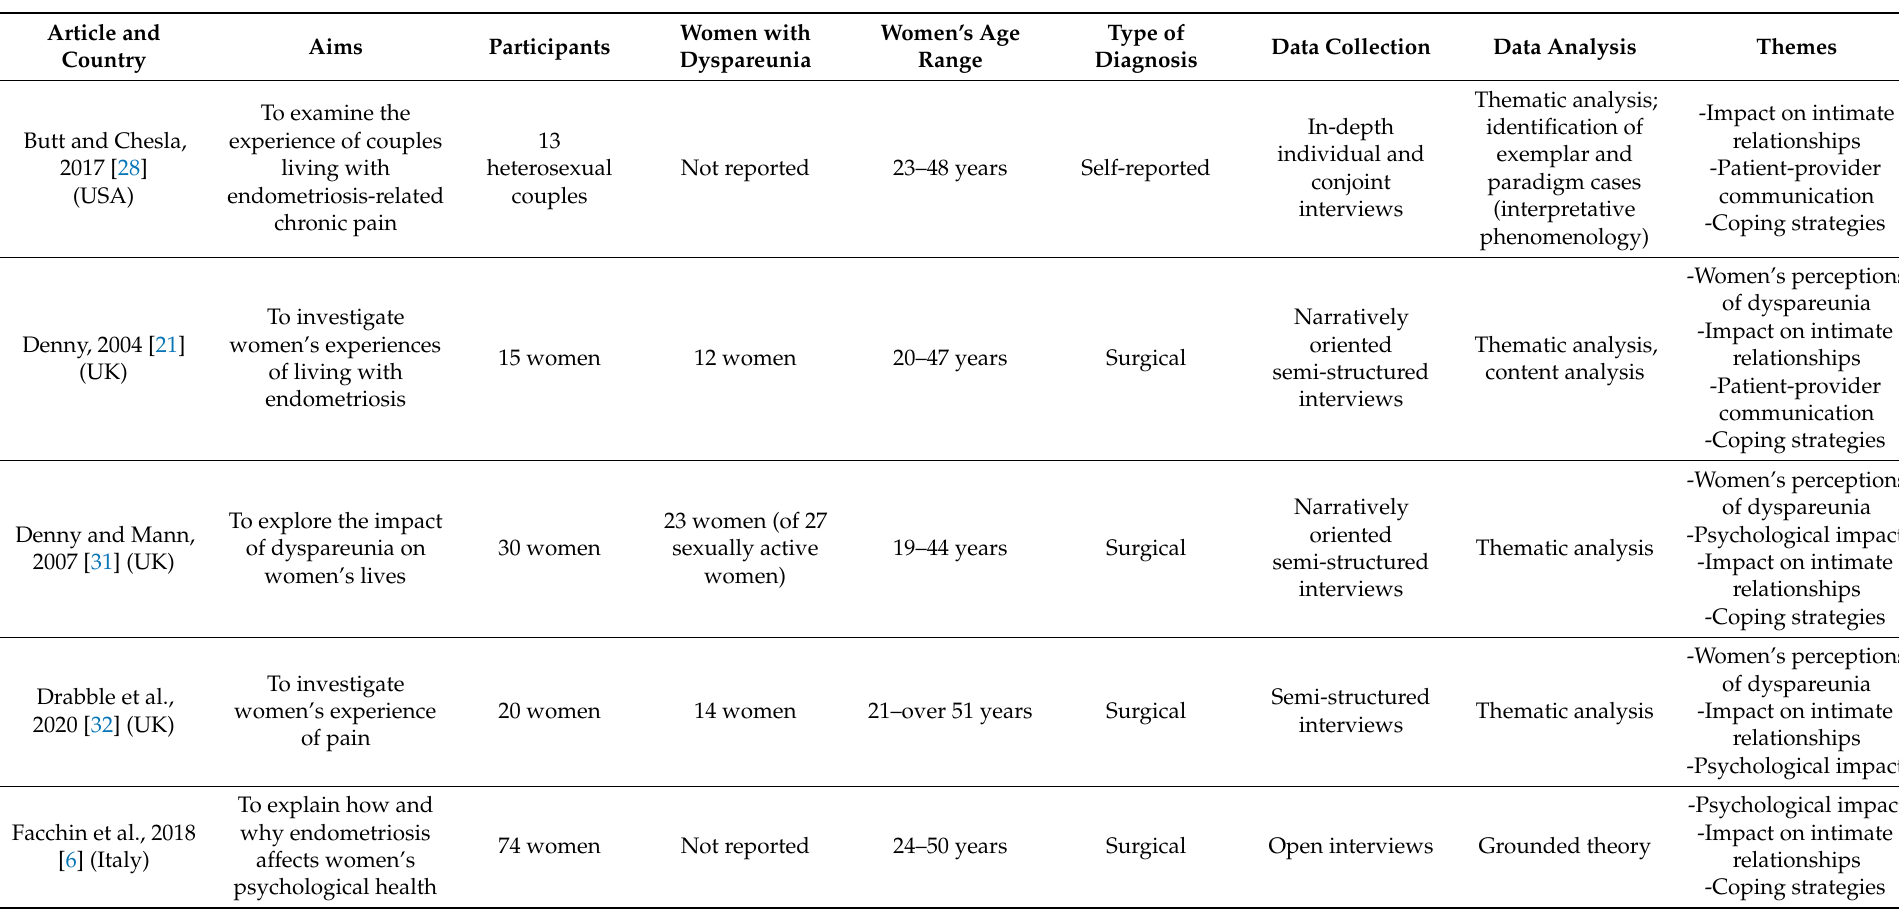
Table 1. Characteristics of the included